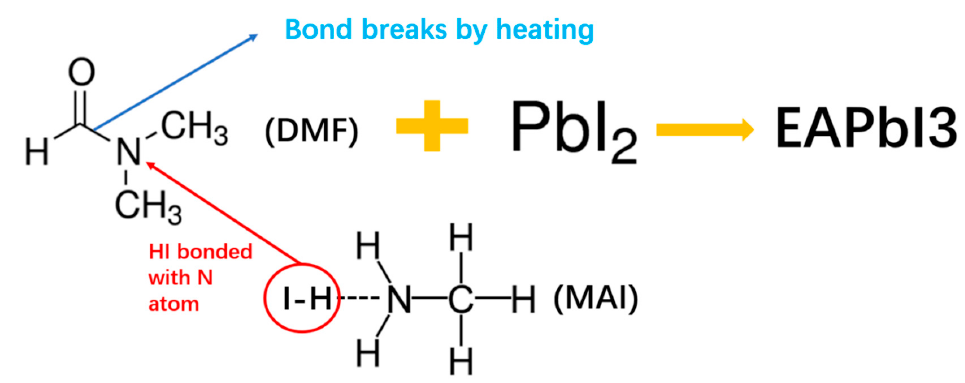
Figure 3. Schematic illustration of EAPbI 3 formation process.